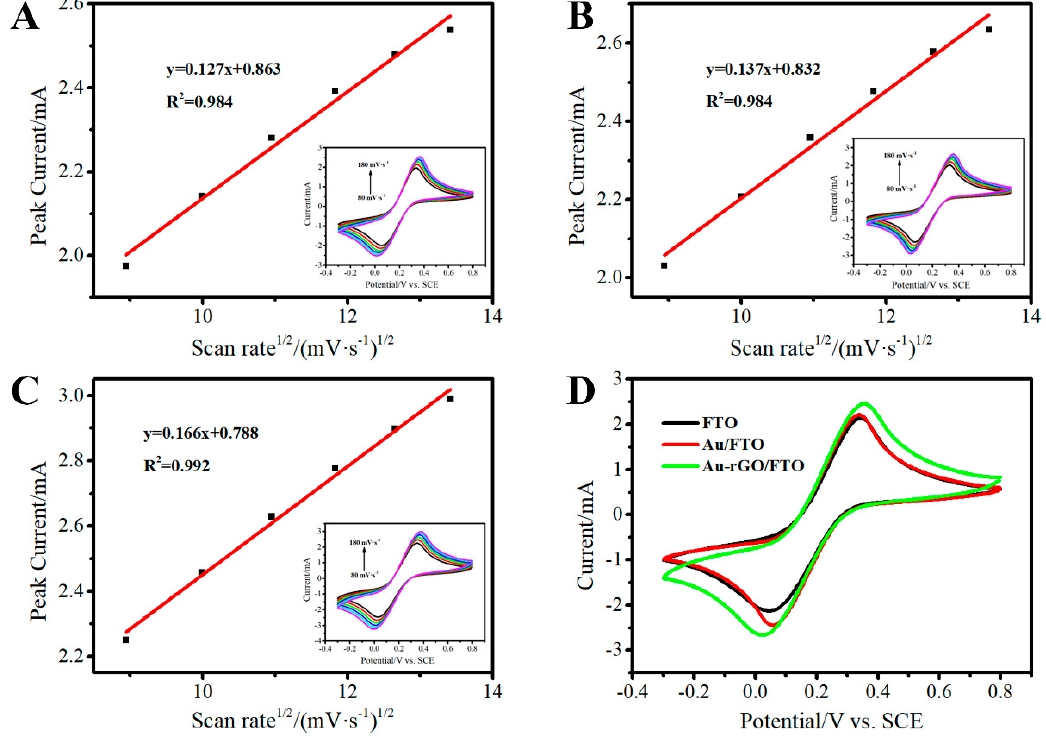
Figure 5. Peak current-scan rate 1/2 responses of the FTO ( A ), Au/FTO ( B ), 3D Au-rGO/FTO ( C ) in K 3 Fe(CN) 6 (insets show the CVs of the corresponding electrode at different scanning rates in K 3 Fe(CN) 6 ), CVs of FTO, Au/FTO and 3D Au-rGO/FTO recorded in K 3 Fe(CN) 6 ( D ). The number of active sites ( 𝑛 (cid:3028)(cid:3030)(cid:3047)(cid:3036)(cid:3049)(cid:3036)(cid:3047)(cid:3052) ) is a critical parameter to explain the electrochemical activity of an electrode or material. It could be estimated via the CVs by the following equation [20,21]: